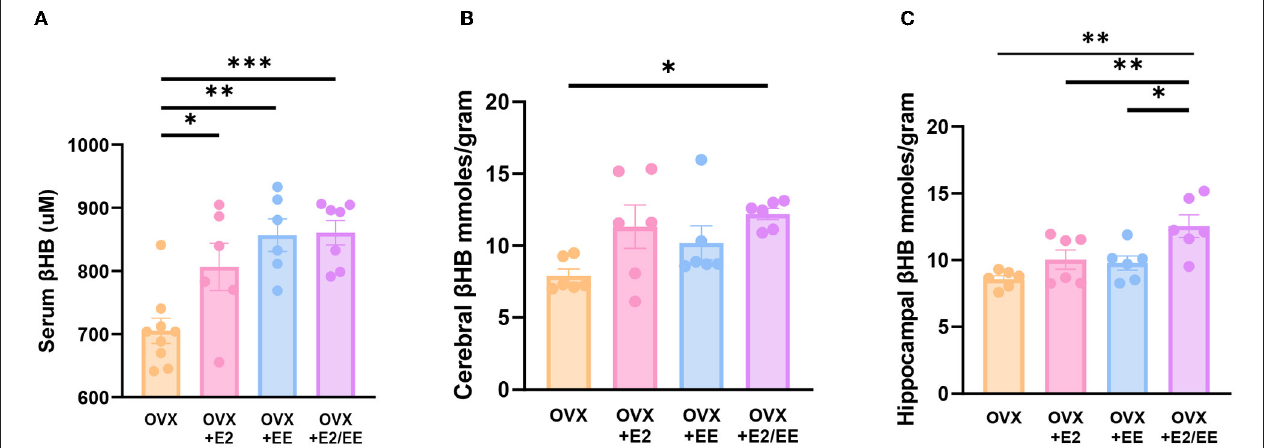
FIGURE 9 | Exposure to EE and estrogen treatment can increase the level of β HB in OVX mice. (A) Serum β HB ( n = 6–9 per group). (B) Cerebral cortex β HB ( n = 6 per group). (C) Hippocampus β HB ( n = 6 per group). One-way ANOVA with Tukey multiple comparison test. Data represented are means ± SEM. * p < 0.05, ** p < 0.01, and *** p <